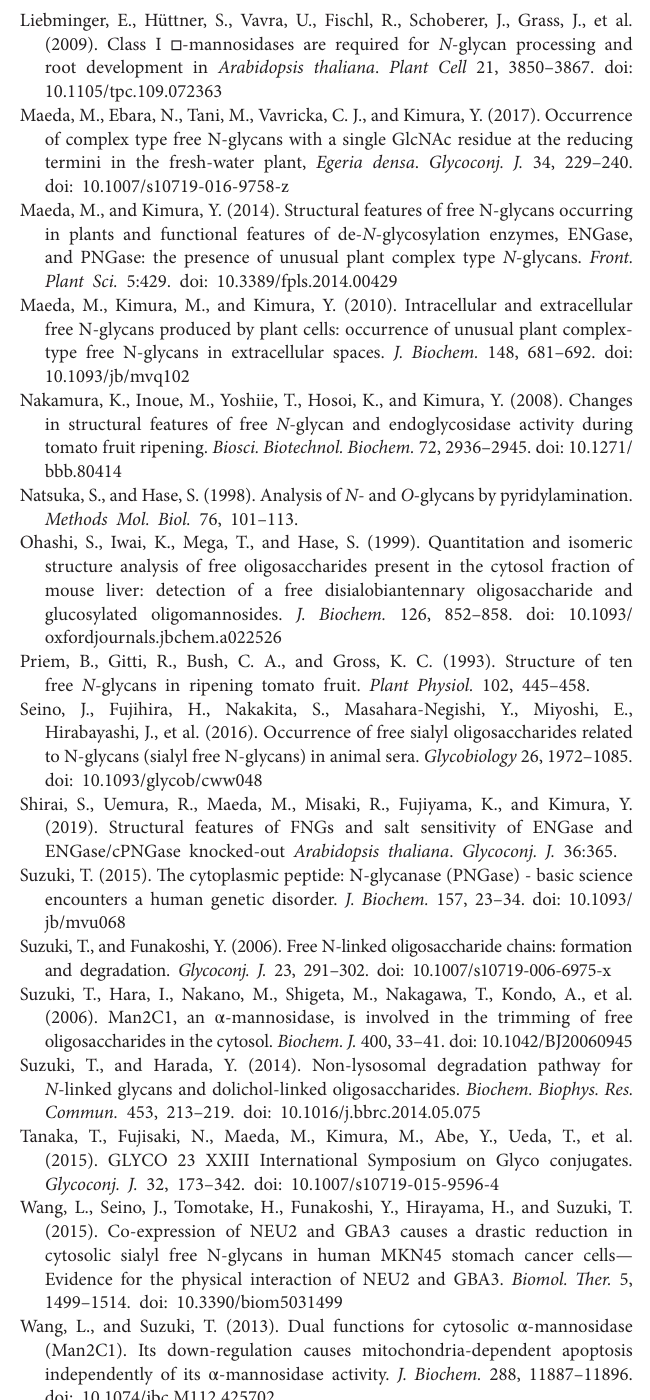
Supplementary Figure 3 | ESI-MS analysis of peak e obtained from F2 (as obtained in Figure 2-II ). (I) ESI-MS analysis of peak e, as obtained in Figure 2-II . (II) MS/MS analysis of a signal at m/z 981.3 [M + 2H] 2+